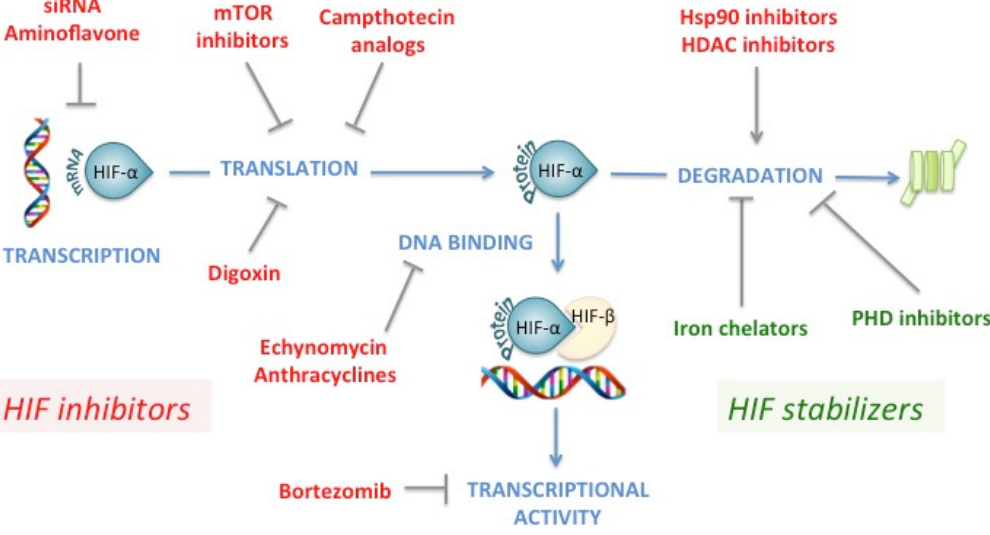
Figure 6. Pharmacological treatments targeting the HIF pathway. Green: stabilization of HIF- α , red: destabilization of HIF - α . Blue arrows: physiological process, grey arrows: activation, grey T arrows: inhibition.